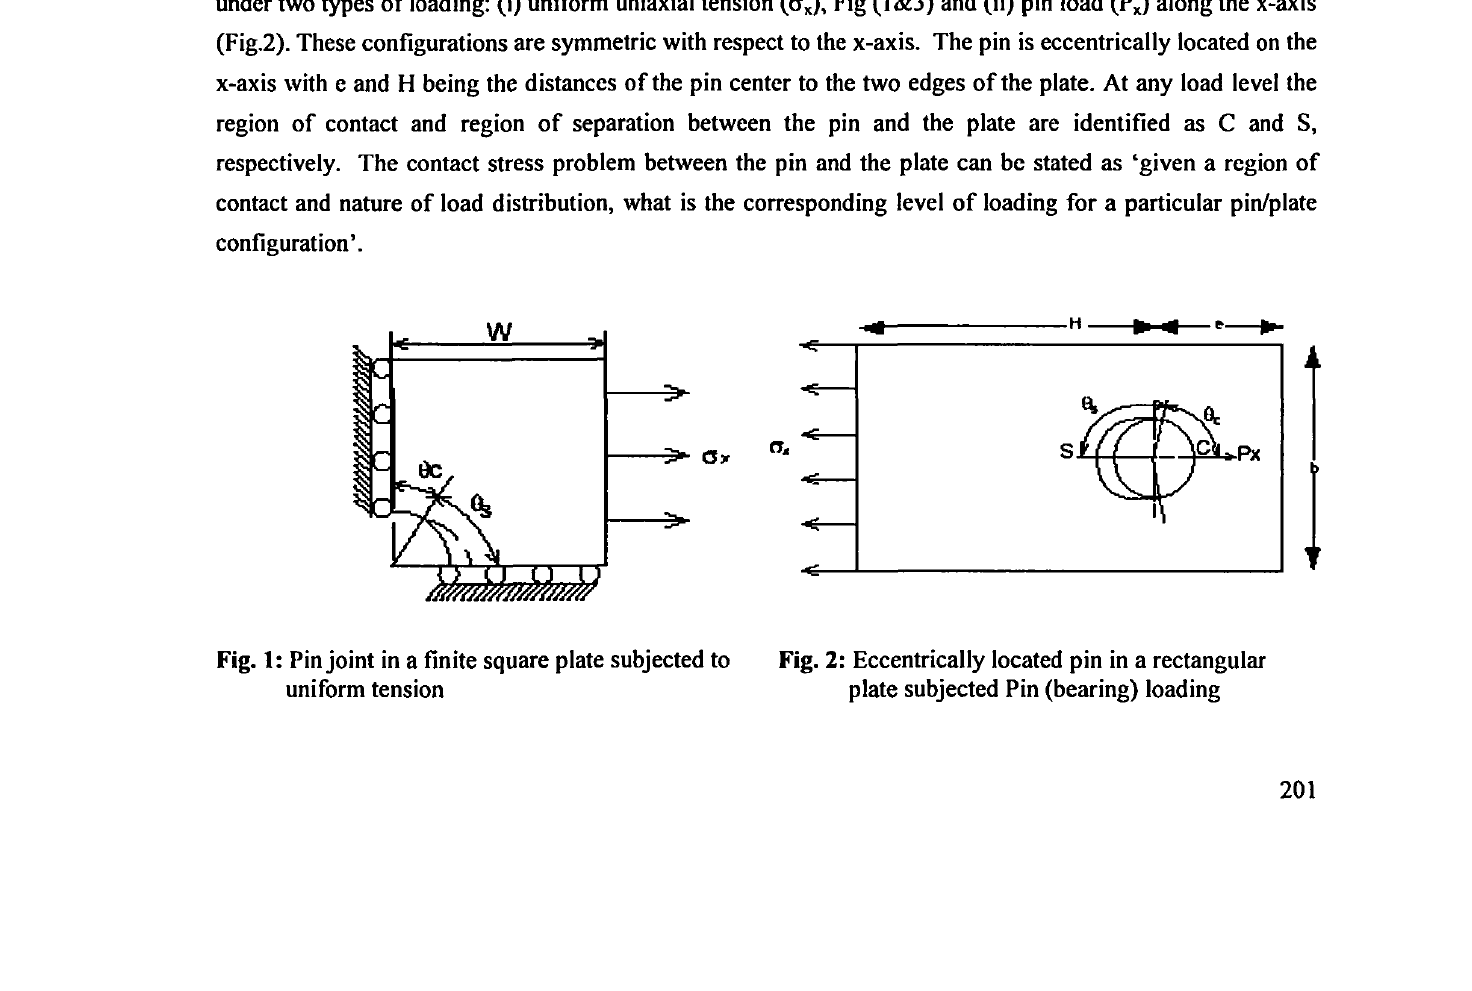
Fig. 2: Eccentrically located pin in a